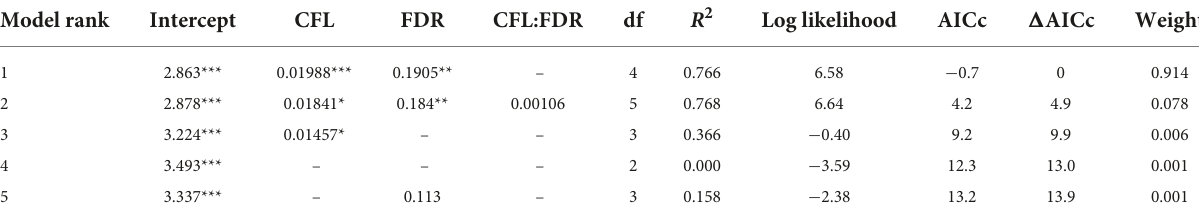
TABLE 2 Model selection table that outlines the effects of capture fuel load (CFL) and fuel deposition rate (FDR) on the natural log of departure fuel load. Model